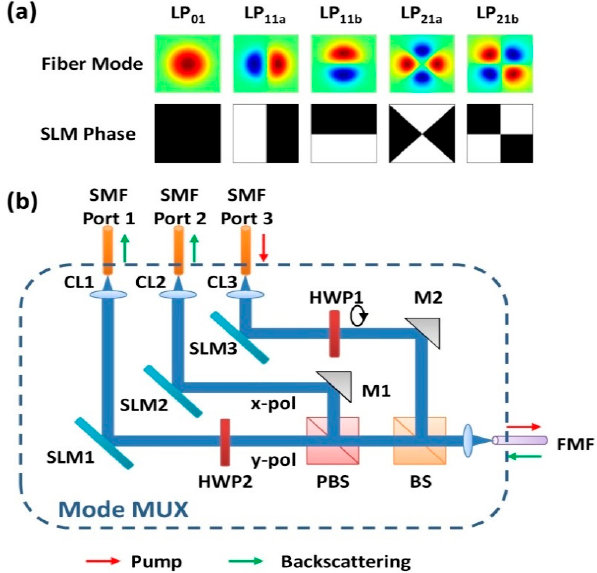
Figure 4. ( a ) Intensity distributions of the first five spatial modes in FMF and their corresponding SLM phase patterns; ( b ) Schematic diagram of the free-space SLM-based M-MUX. CL1~CL3: collimating lens, M1/M2: turning mirrors, HWP1/HWP2: half wave-plates, BS: beam-splitter, PBS: polarizing beam-splitter [77].